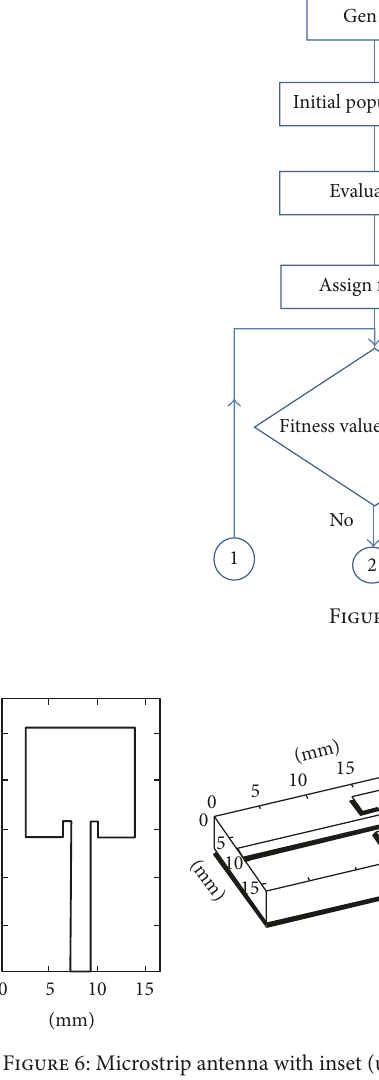
chromosome sizes were tested. A digital individual with computational burden.